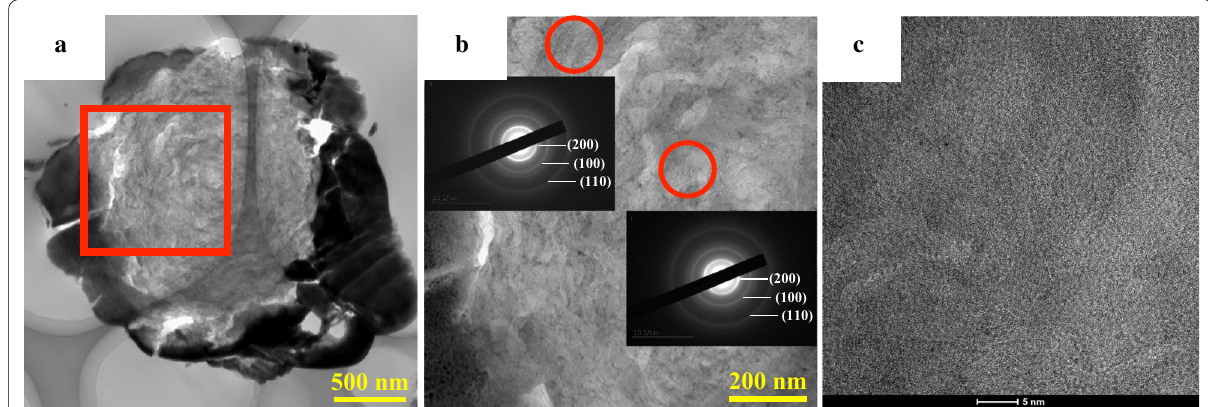
Fig. 4 Microstructure of the presolar graphite (Pink-55a). a Consisting of concentric layers. b The area with red box at high magnification. Electron diffraction pattern from the near red circle indicative of poor organization. c High-resolution TEM imaging. Turbostratic layering with contorted lattice planes and short-range layer